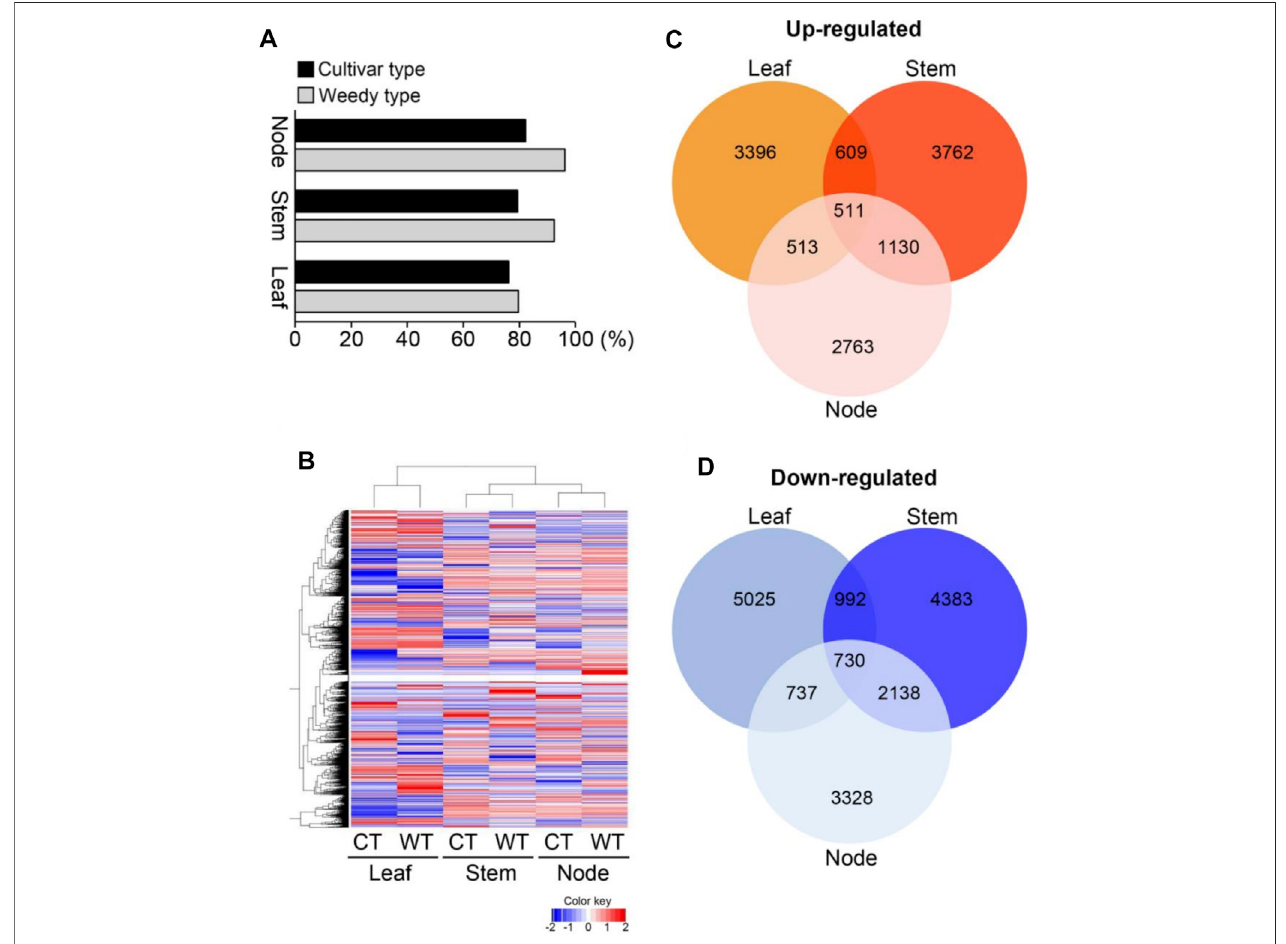
FIGURE 2 | Transcriptome analysis of leaves, stems, and nodes of weedy type (WT) and cultivar type (CT) soybean. Total RNA was prepared from leaves, stems, and nodes of12-week-oldplants. (A) Mappingofsequence reads tothe reference Glycinemax Wm82.a2. v1. (B )Hierarchical clusteranalysisofdifferentially expressed genes (DEGs). Color key indicates gene expression FPKM values from − 2 to 2: blue = lowest and red = highest among the DEGs between leaves, stems, and nodes of WT and CT. (C) and (D) Comparisons of the number and overlapping relationship of the DEGs between leaves, stems, and nodes of WT and CT. Red circles indicate up-regulated genes (C) and blue circles represent down-regulated genes (D) in cultivar type with respect to weedy type ( > log 2 fold change).